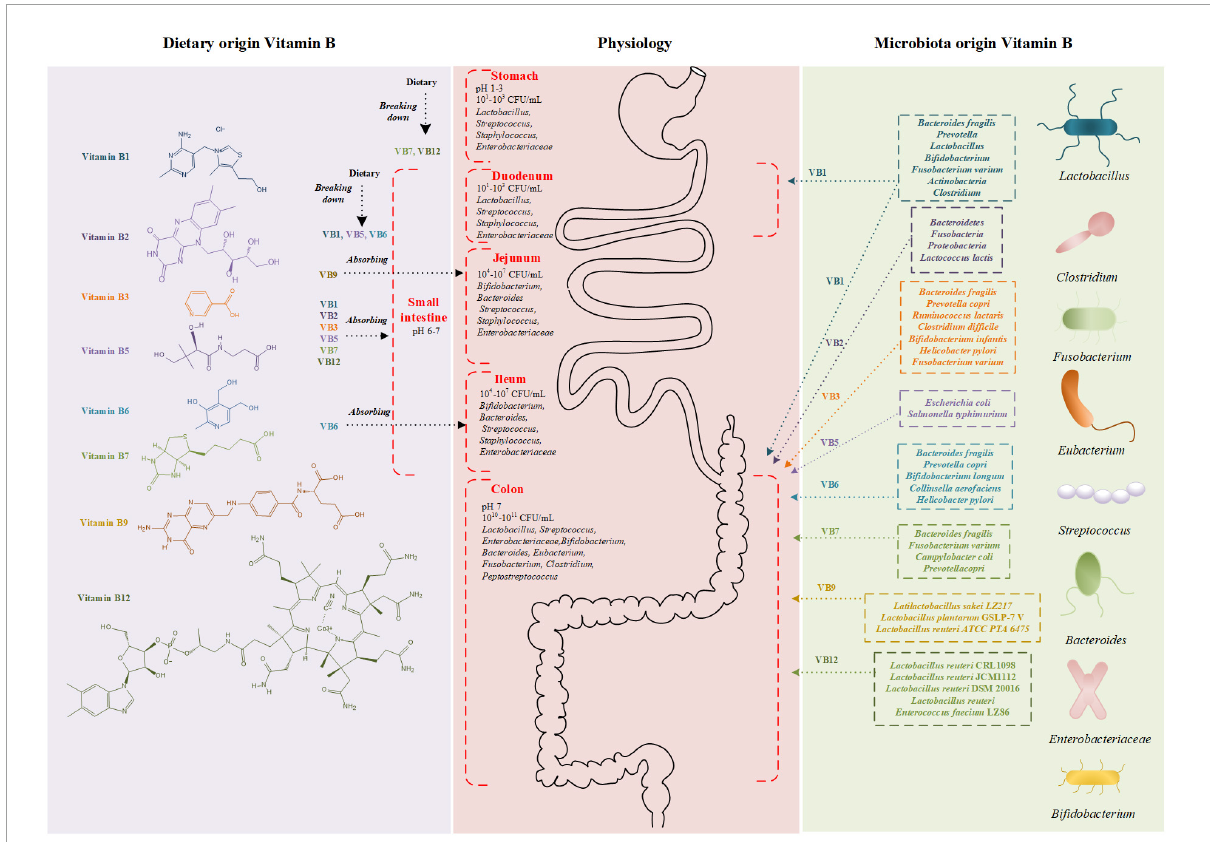
FIGURE1 Schematic diagram of vitamin B structure and absorption sites. Vitamin B derived from diet (left) and microbiota (right) are absorbed in gastrointestinal tract (middle) . The different colors represent bacteria producing different vitamin B. CFU, colony forming